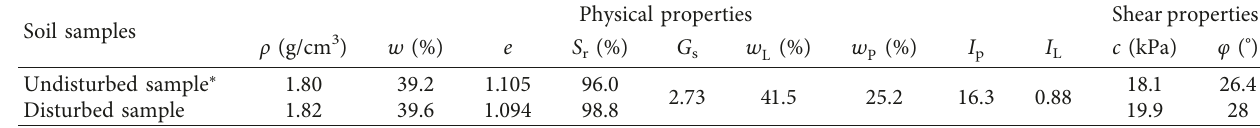
Table 1: Physicomechanical properties of soft